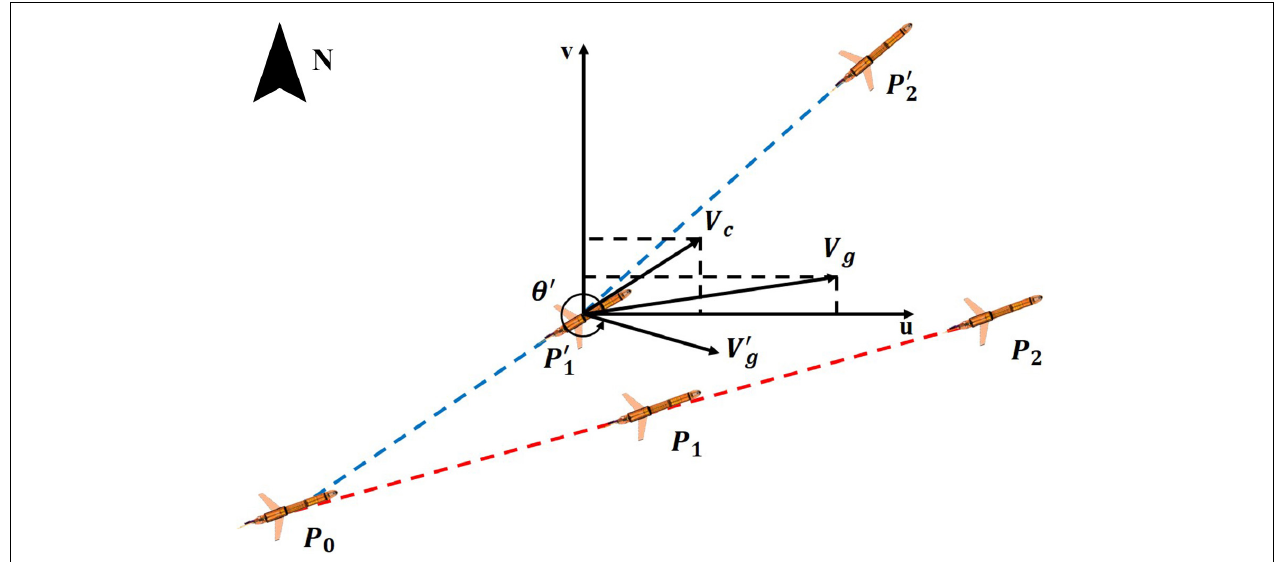
FIGURE 2 | Diagram presents the process of heading angle correction at surface point. The red dotted line represents the predetermined route, and the blue dotted line represents the actual trajectory.